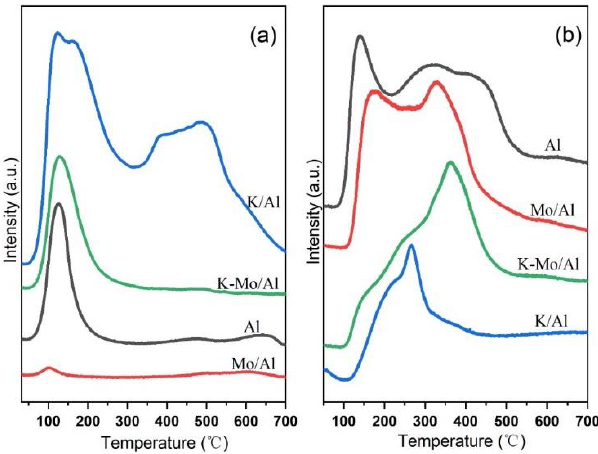
Figure 5. H 2 -TPR spectra of the fresh catalysts.